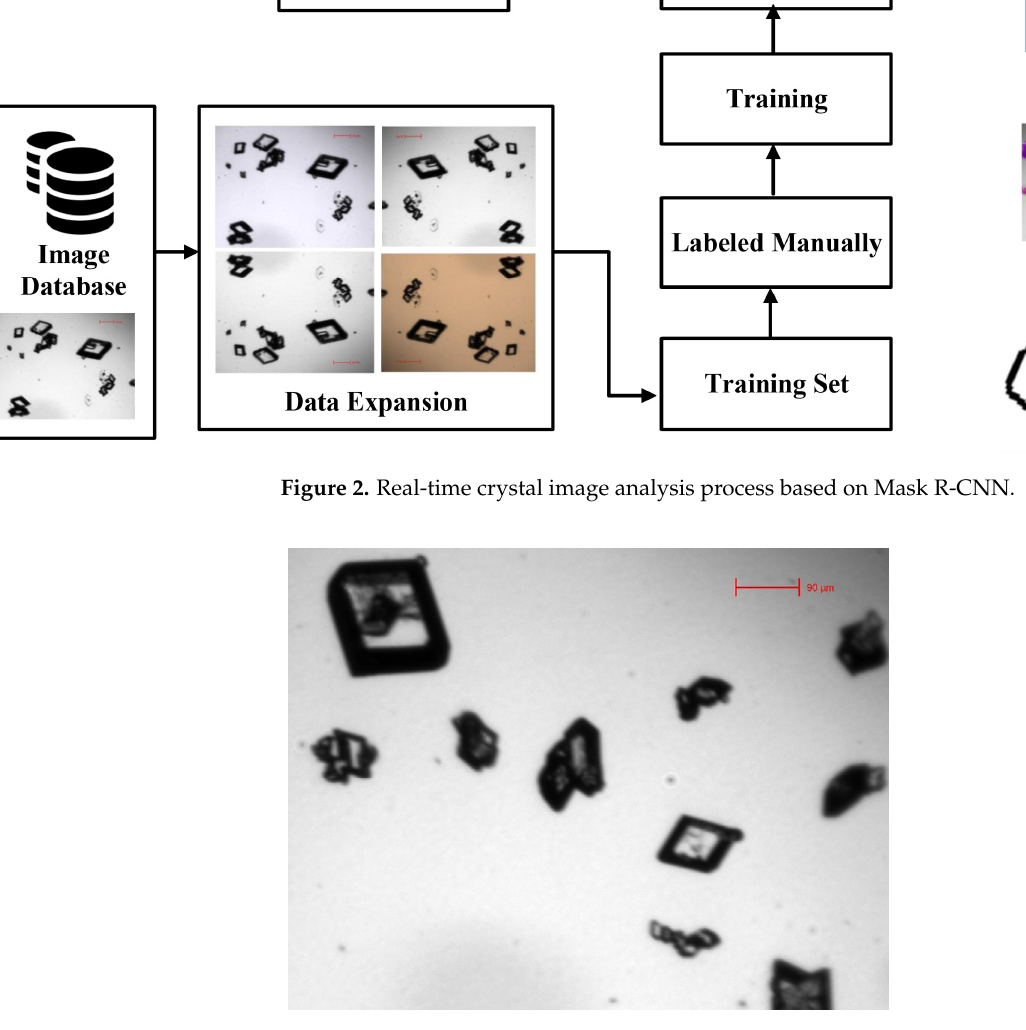
Figure 3. Original crystal image.